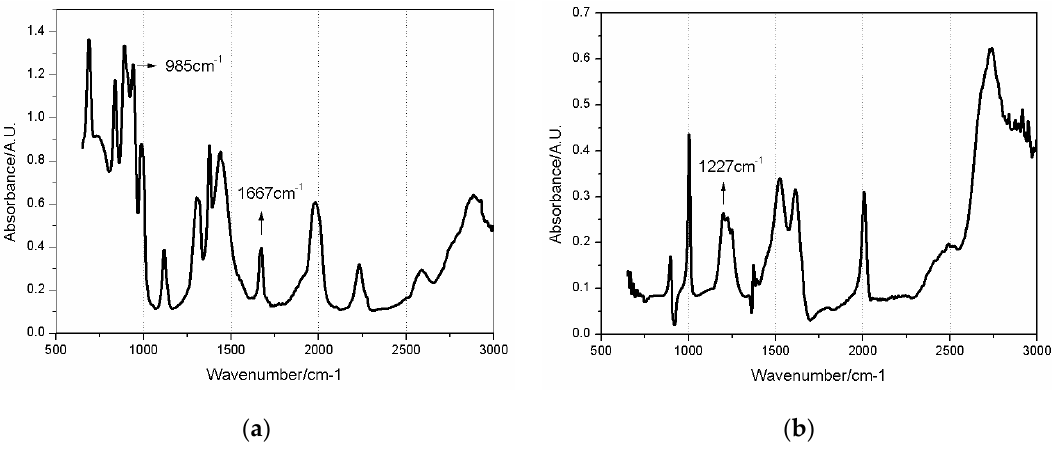
Figure 9. The infrared spectrum of pure substances acquired by ReactIR15: ( a ) IR spectrum of acetaldoxime and ( b ) IR spectrum of hydroxylamine.